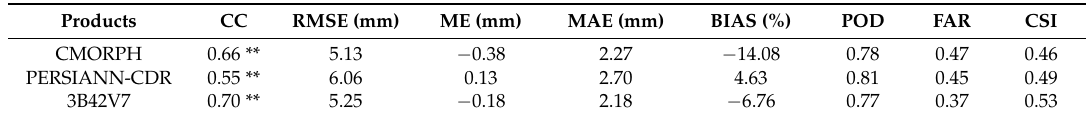
Table 2. Summary of statistical metrics for the three satellite precipitation products. The metrics were calculated based on grids with gauges.